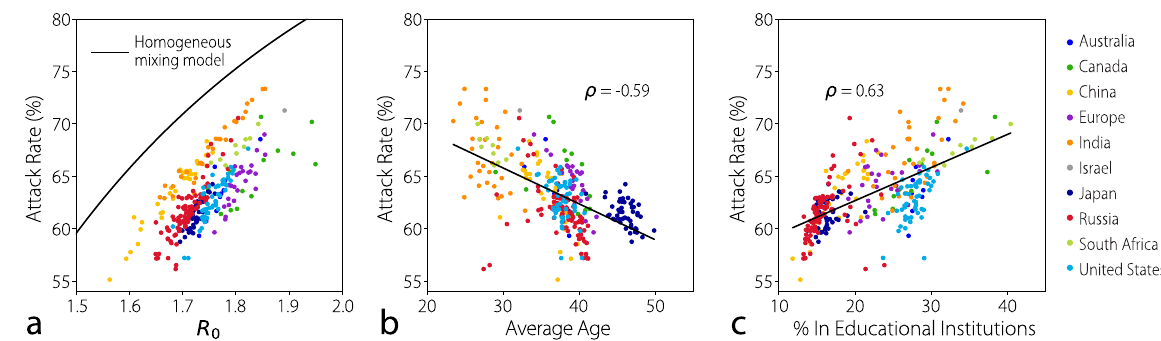
Fig. 6 Epidemic impact. a Scatter plot of the attack rate and the reproduction number R 0 from an age-structured SIR model using the contact matrix for each subnational location. European countries are included. The black line shows the results of the classic homogeneous mixing SIR model (no age groups). b Scatter plot of attack rates and the average age in each location. The black line represents the best- fi tting linear model demonstrating a negative linear correlation between attack rates and the average age of the population. c Scatter plot of attack rates and percentage of the population attending educational institutions in each location. The black line represents the best- fi tting